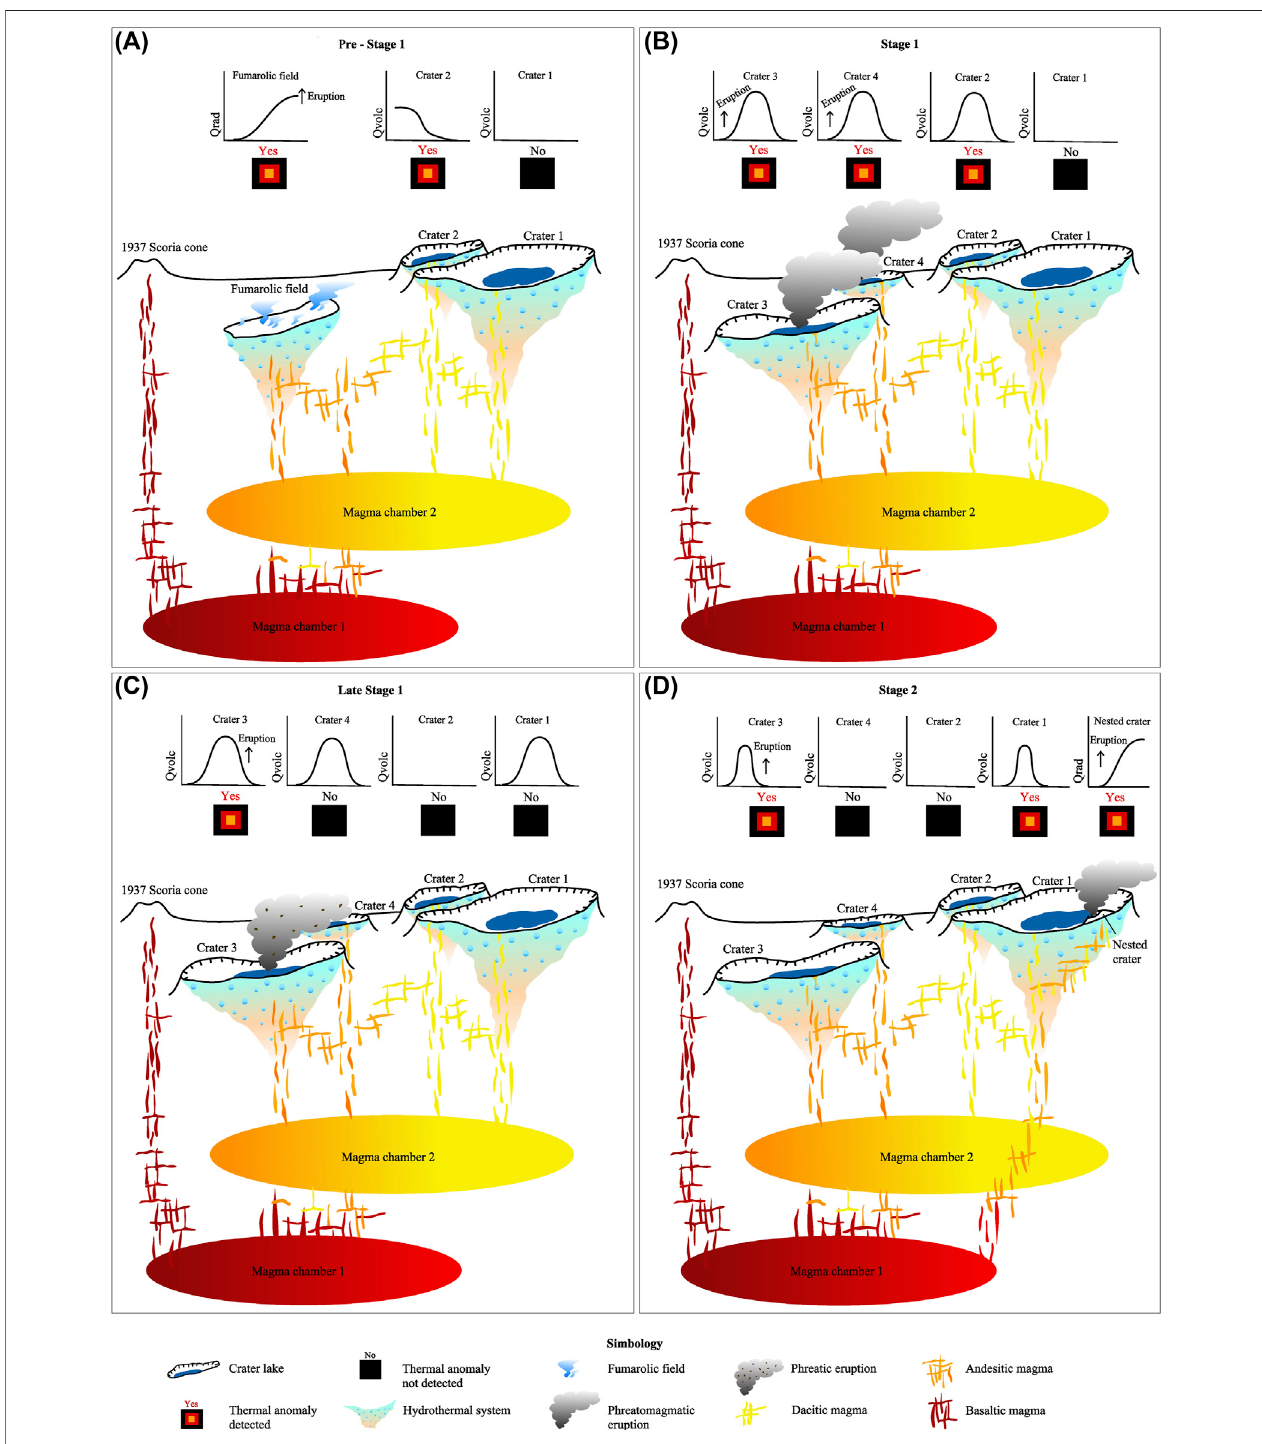
FIGURE 10 | Conceptual model of Peteroa volcano evolution between 1984 and 2020. (A) Pre-Stage 1 (1984-January 1991). (B) Early Stage 1 (February 1991 – August2010). (C) LateStage1(September2010 – July2011). (D) Stage2(June2017 – December2020).Presence/absenceofthermalanomaliesandbehaviorof Q volc and Q rad are also shown. Model not to scale.